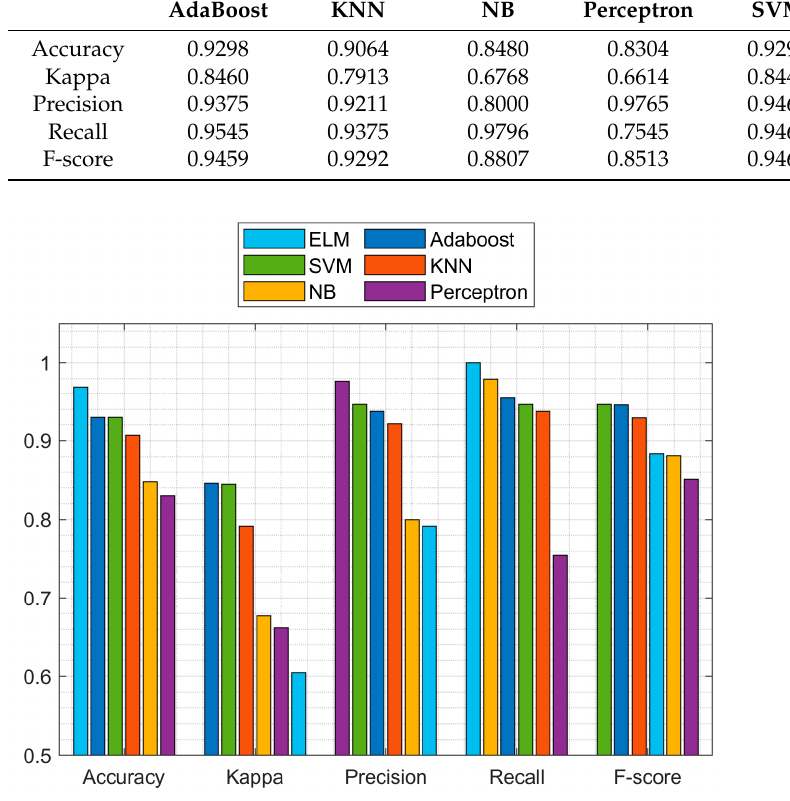
Figure 5. Graphical representation of the model performance (standalone